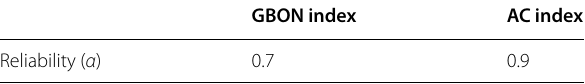
Table 1 Chronbach’s α reliability scores for GBON and AC